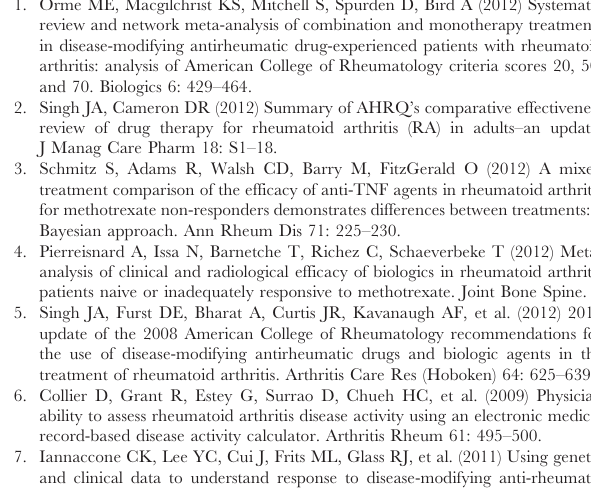
Figure S1 20 top-ranked user-defined customized dic- tionary features. Their related Chi-square values were visualized as bars. Longer bars suggest higher impact. Figure S2 20 top-ranked unigram and word-CUI bi- gram features. Their Chi-square values were visualized as bars. Longer bars suggest higher impact. The negative signs ‘‘-’’ before some of the CUIs suggest negation. A bigram is formatted as Figure S3 20 top-ranked word features. Their related Chi- square values were visualized as bars. Longer bars suggest higher impact. ‘‘hapatospleno’’ is the stemmed form of ‘‘hepatospleno- megaly’’. Figure S4 ROC curves of five models tested on the Test set 1. From top to bottom: (1) The linear-kernel SVM model trained on High and Remission cases of the Training set, using selected CUI features and lab values; (2) The RBF-kernel SVM model trained on High and Remission cases of the Training set, using selected CUI features and lab values; (3) The linear-kernel SVM model trained on all notes of the Training set, using selected CUI features and lab values; (4) Baseline system 2, which is a linear kernel SVM model on all BOW features with lab values; (5) Baseline system 1, which is a linear kernel SVM model on all BOW features without lab values.